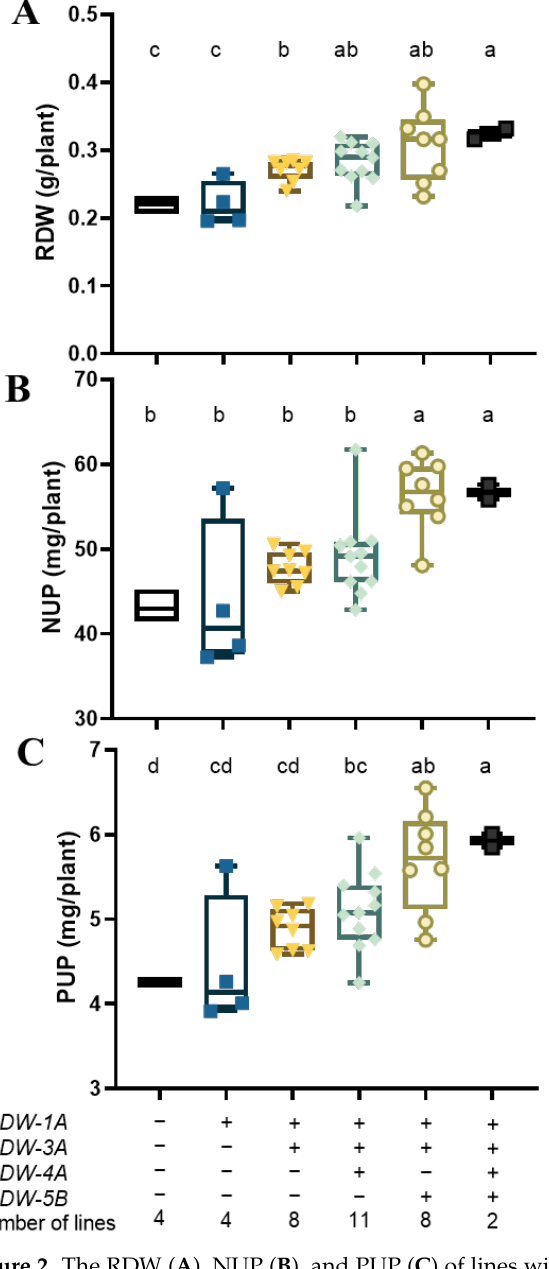
Figure 2. The RDW ( A ), NUP ( B ), and PUP ( C ) of lines with varying combinations of RDW QTLs in the “Xiaoyan 54 × Jing 411” RIL population. The values of six groups of lines were compared, each group harbors null, one, two, three, or four favorable alleles of RDW QTLs. “+” represents a favorable allele, while “ − ” represents an unfavorable allele. The median is indicated by the solid horizontal line. Vertical lines represent the range. Statistical differences are indicated by different letters above the boxes. Boxes that do not possess the same letter(s) mean significance at p < 0.05 level (Duncan’s multiple range